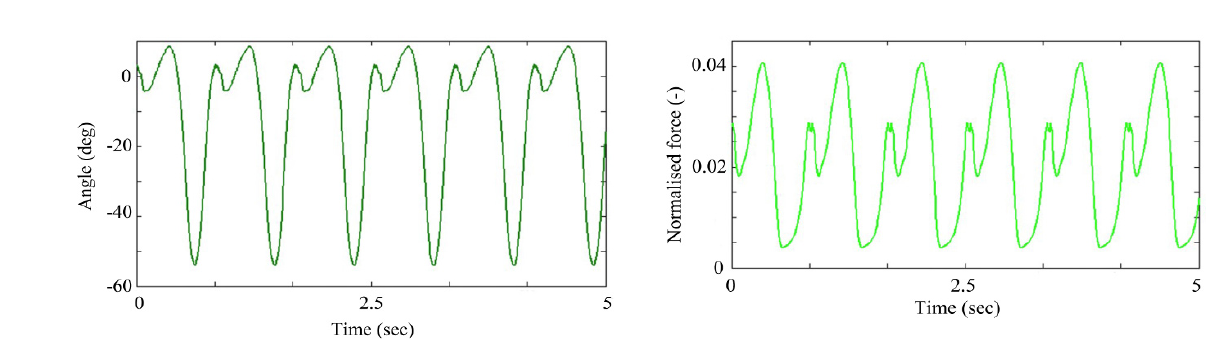
Figure 2. Angle-time diagram of mean knee joint angle.